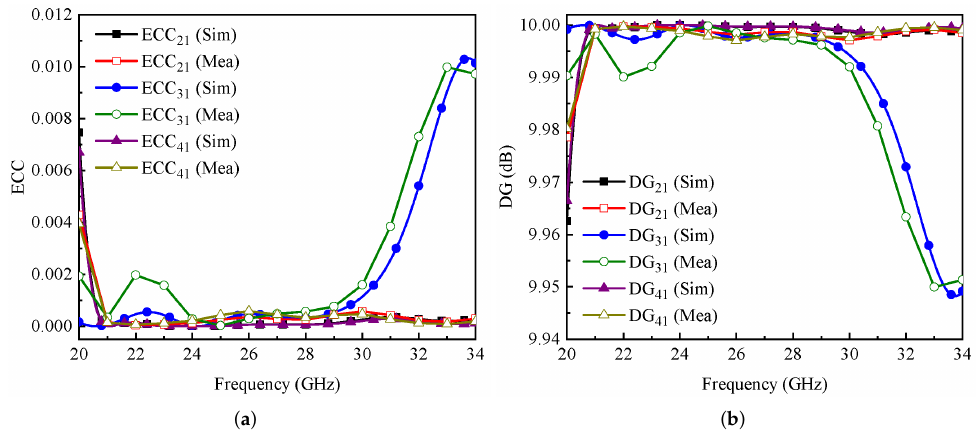
Figure 11. ( a ) Envelope correlation coefficient and ( b ) diversity gain of the proposed MIMO antenna.